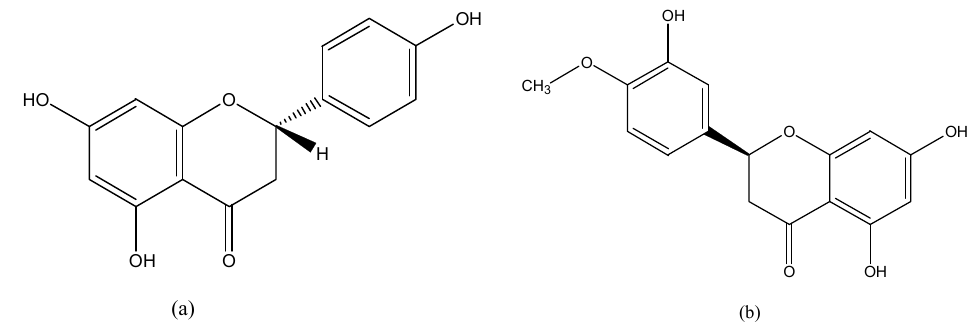
Figure 4. The chemical structures of naringenin ( a ) and hesperetin ( b ).